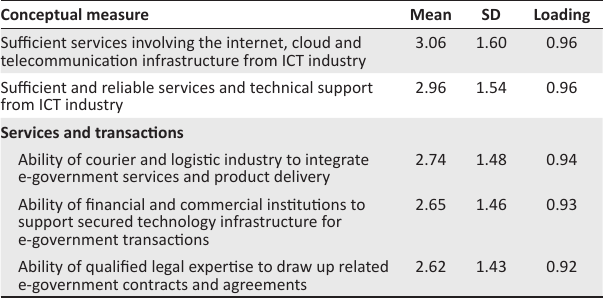
TABLE 7: Confirmatory factor analysis of supporting industries readiness.